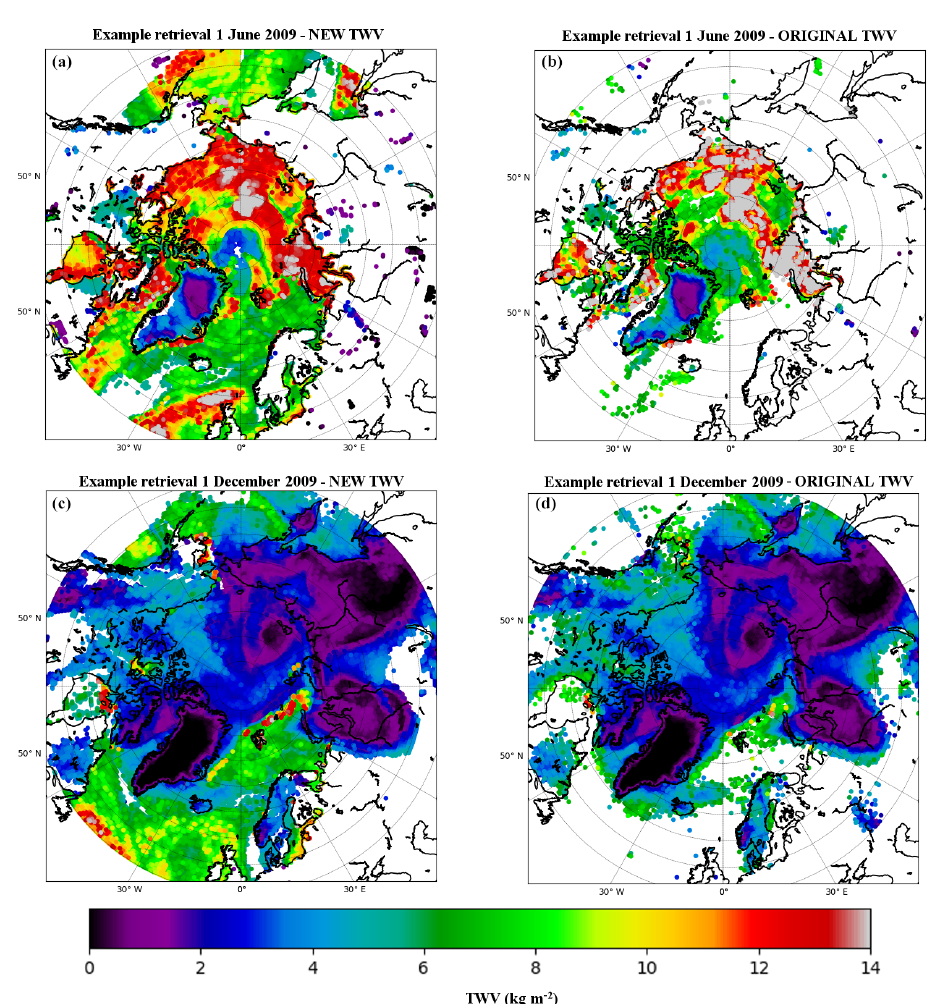
Figure 4. Daily TWV maps of the Northern Hemisphere obtained from the new algorithm (a, c) and compared to the original AMSU-B algorithm (b, d) . The days represented here are 1 June 2009 for (a) and (b) , and 1 December 2009 for (c) and (d)